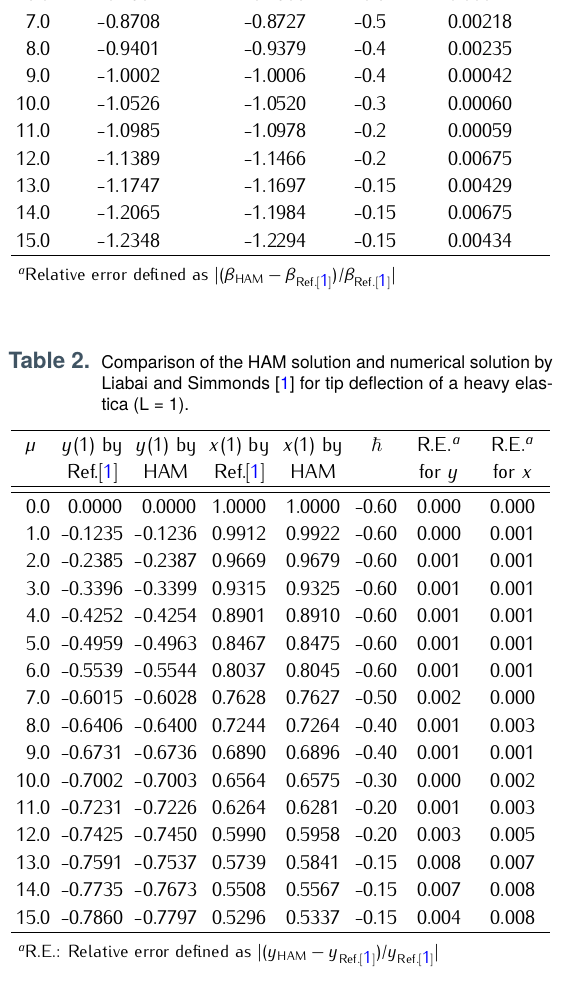
imation of the term cos( β ) by Taylor series causes some small errors which can be considered negligible. If µtakes large values, the governing nonlinearity of the problem in Eq. 9 will appear, but even in this case HAM gives accu- rate results. According the obtained solution in compari- son with the numerical results in Table 1 and 2, a remark- able accuracy even for large µis observed. The HAM so- lution for slope and deformed configuration of